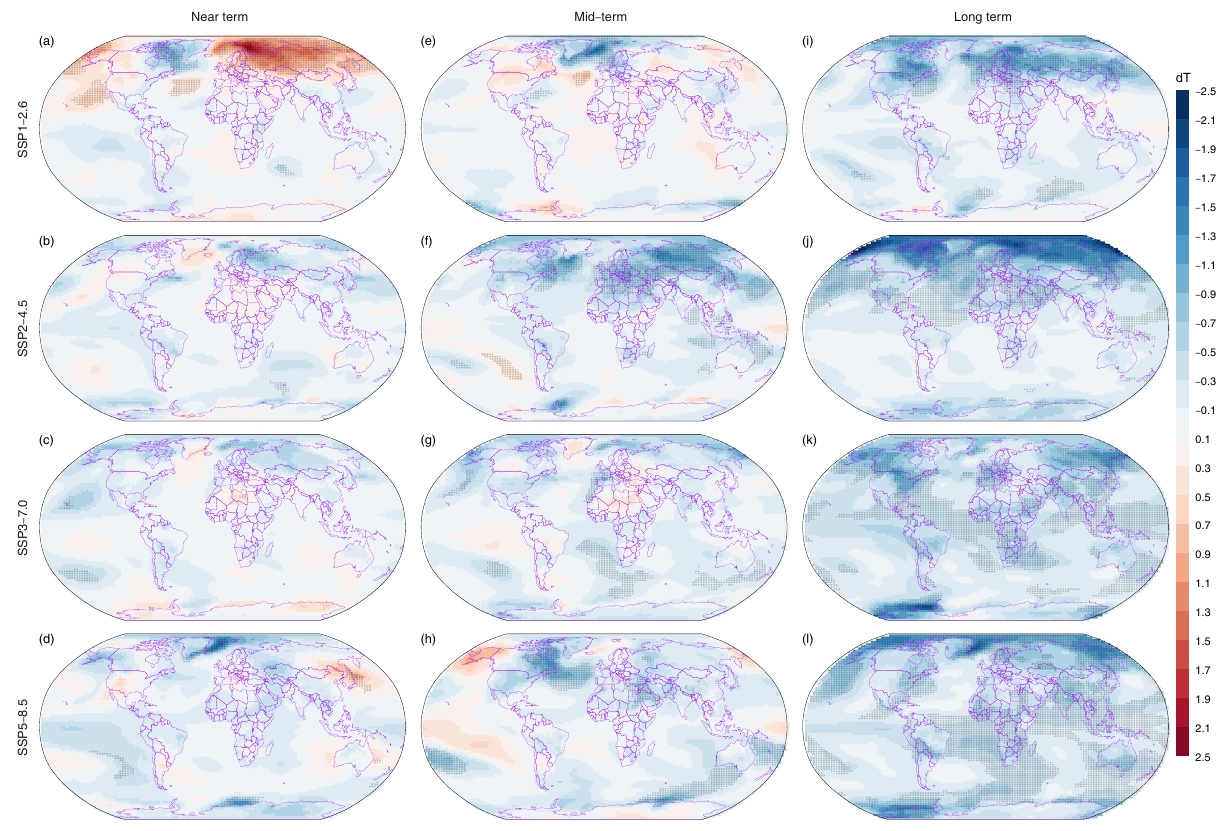
Fig.3|Meansurfacetemperaturedifferencebetweenextensionscenarioswith additionalCH 4 andNO 2 emissionreductionsaccompaniedbytheCO 2 emission reductions for China ’ s carbon neutrality (CNCN ext ) and default CMIP6 scenarios for four shared socioeconomic pathways (SSPs). Panels from lefttorightrepresentthenearterm(2021 – 2040, a – d ),mid-term(2041 – 2060, e – h ) andlongterm(2081 – 2100, i – l ),andpanelsfromtoptobottomrepresentSSP1-2.6,